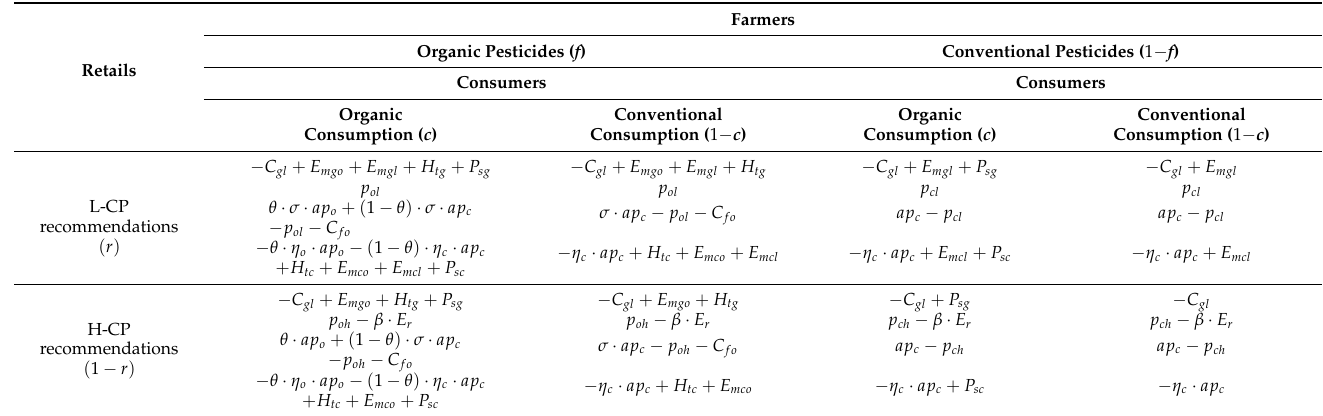
Table 3. Quadrilateral evolutionary game payoff matrix when local governments choose loose regulation (1 − g